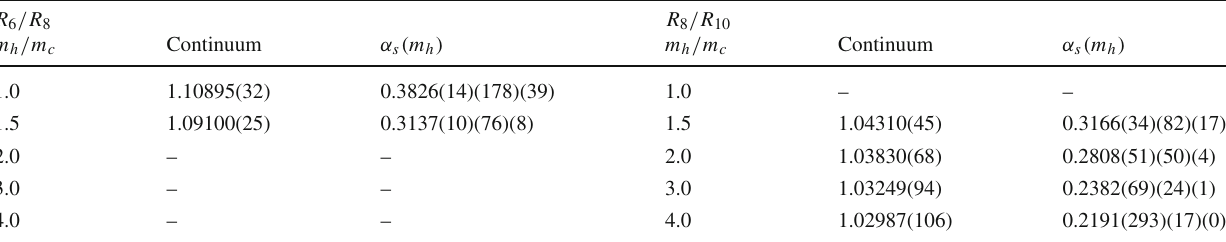
Fig. 6 The lattice results and the continuum extrapolations (fits) for R 6 / R 8 (left) and R 8 / R 10 (right), see text Table 4 The continuum values of the ratios R 6 / R 8 and R 8 / R 10 and the corresponding coupling constants α s (μ = m h ) for different values of the heavy-quark masses m h , see